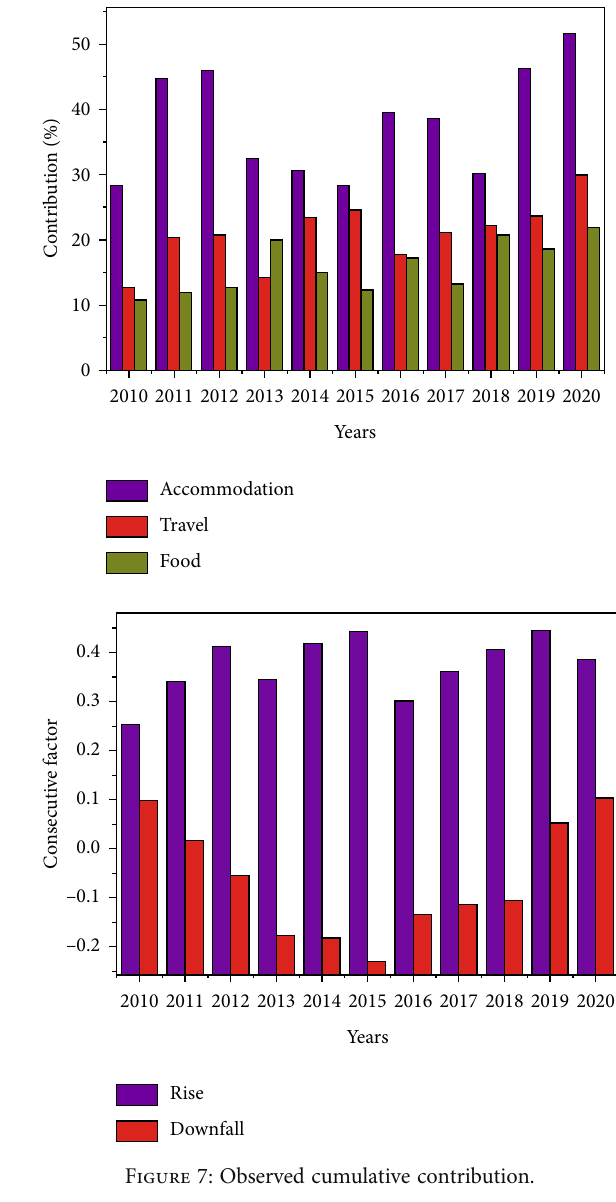
Figure 7: Observed cumulative